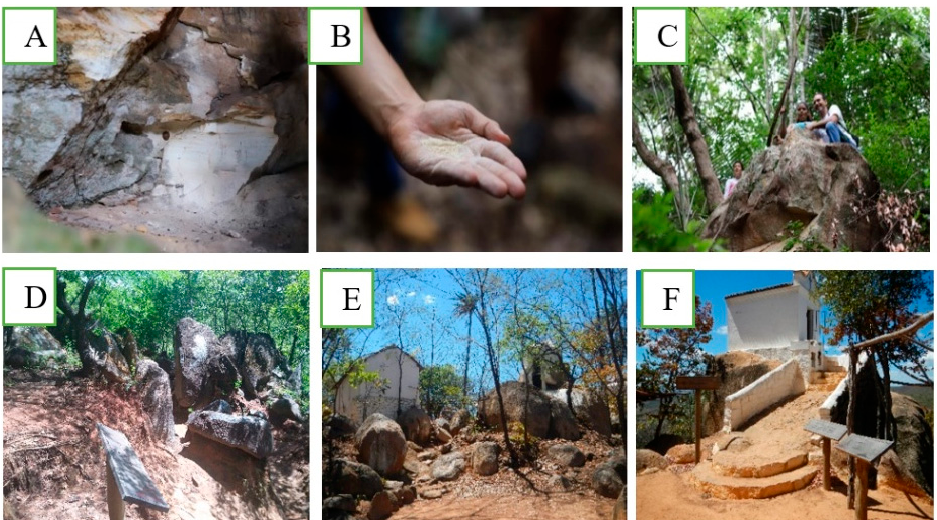
Figure 4. Geodiversity on the Riacho do Meio ( A – C ) and Santo Sepulcro ( D – F ) trails, Araripe UGG. ( A )—Sandstone from the Exu Formation of the Araripe Basin; ( B )—Sediment from the Exu Formation; ( C )—Exu Formation Pedra do Morcego (Sandstone Block); ( D )—Granitic outcrops with historical and cultural meanings; ( E )—Granitic outcrops on the trail; ( F )—Senhora Santana Chapel, built on a large granite block. Source: Research Collection.